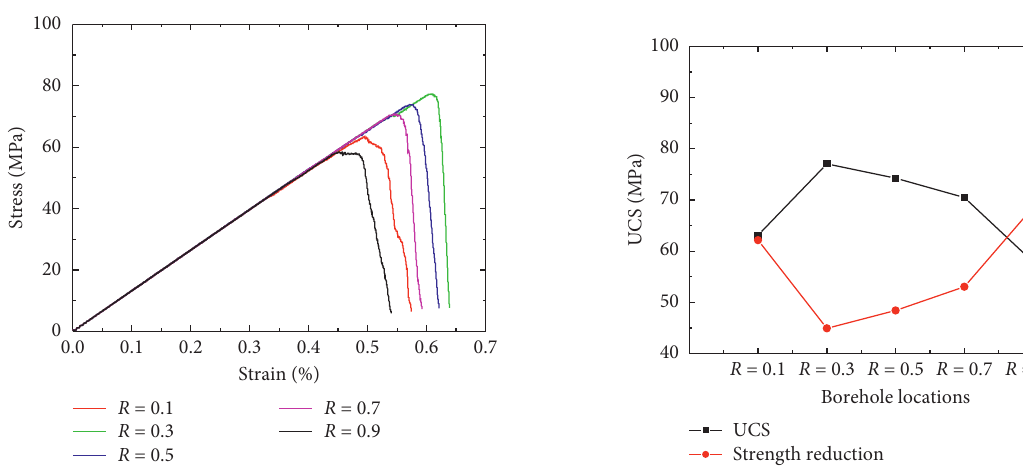
Figure 9: Strength reduction curves of rock samples with different drilling